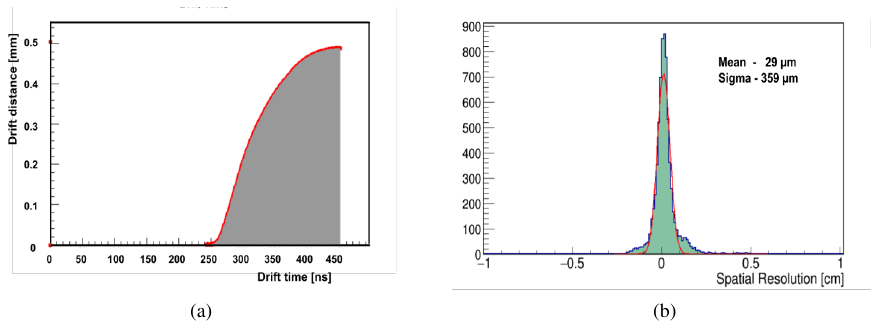
Figure 2: (a) Calibration curve representing the correlation between the drift time and drift radius and (b) Spatial resolution from 256 straws measured for cosmic rays being 359 µ